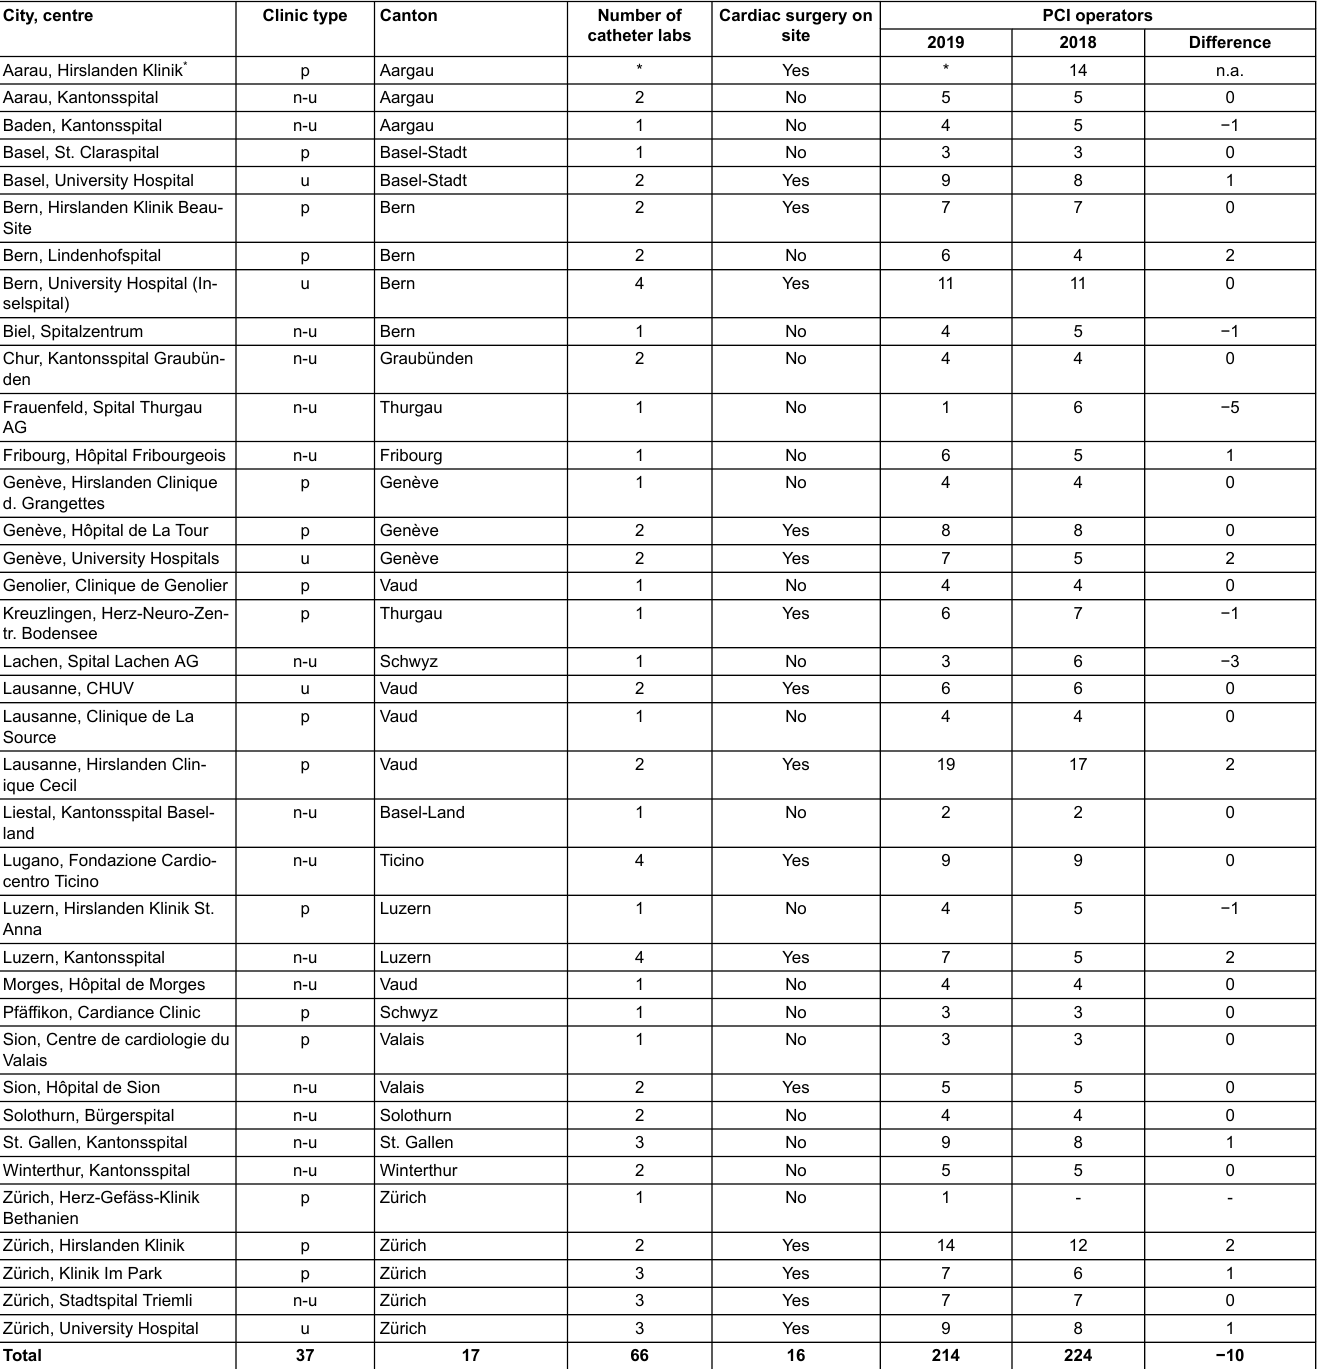
Table 1: Interventional cardiology centres in Switzerland 2019. City,